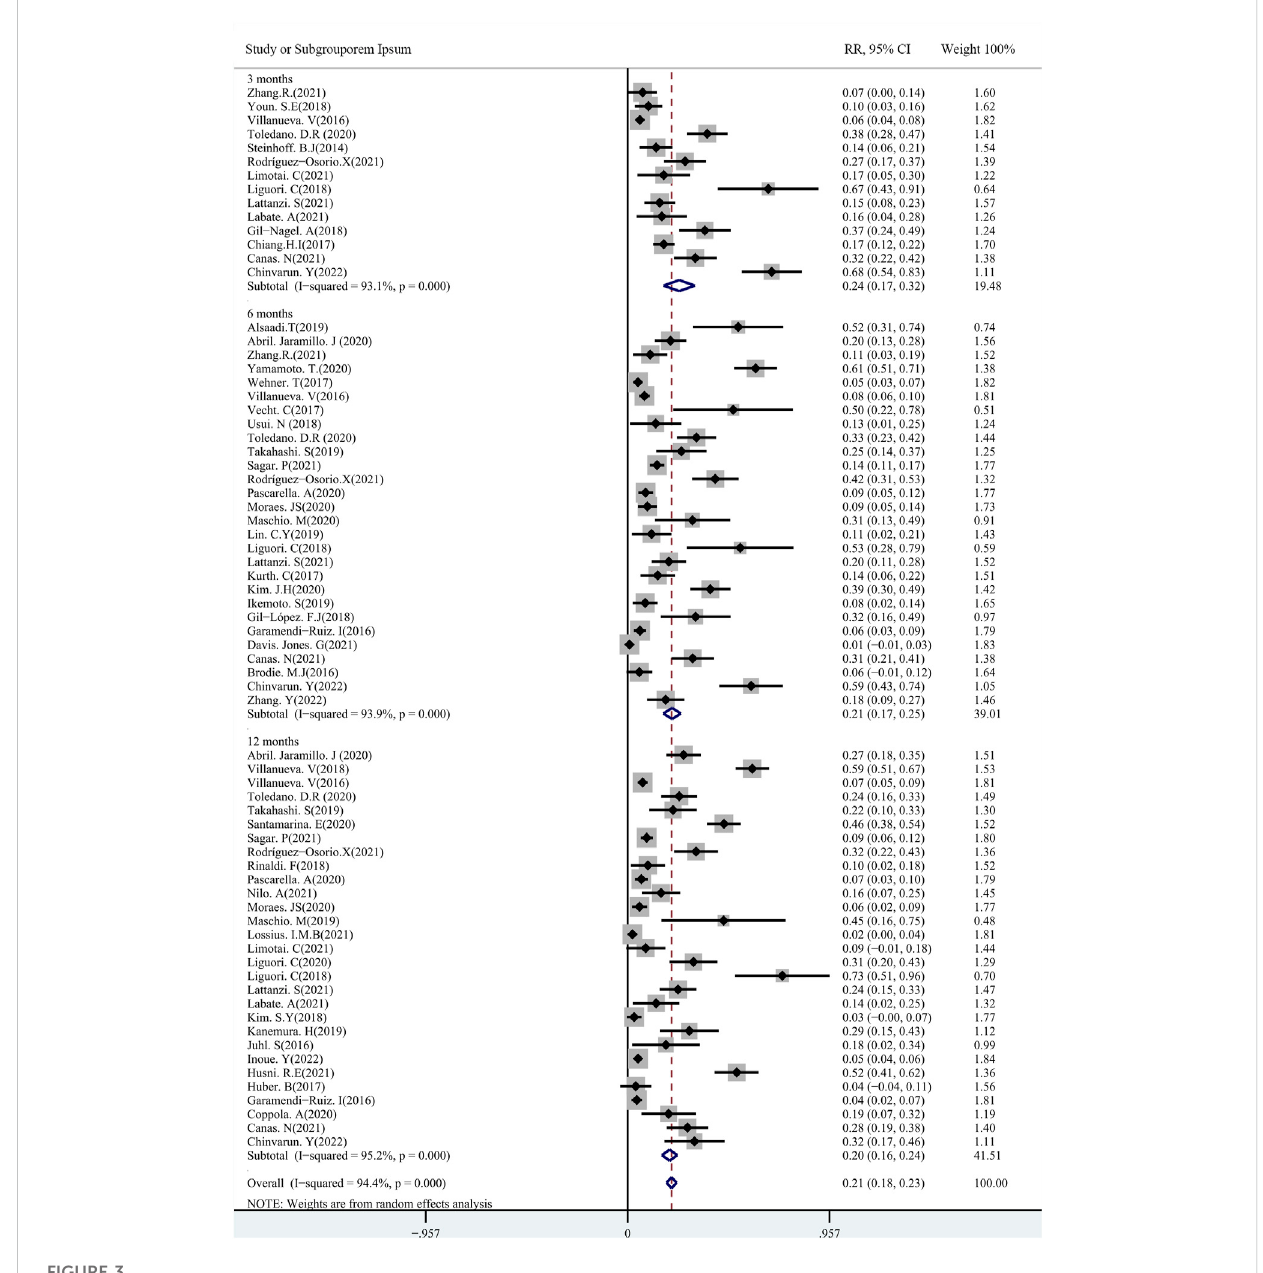
FIGURE 3 Meta-analysis of seizure-free rate: pooled data from 47